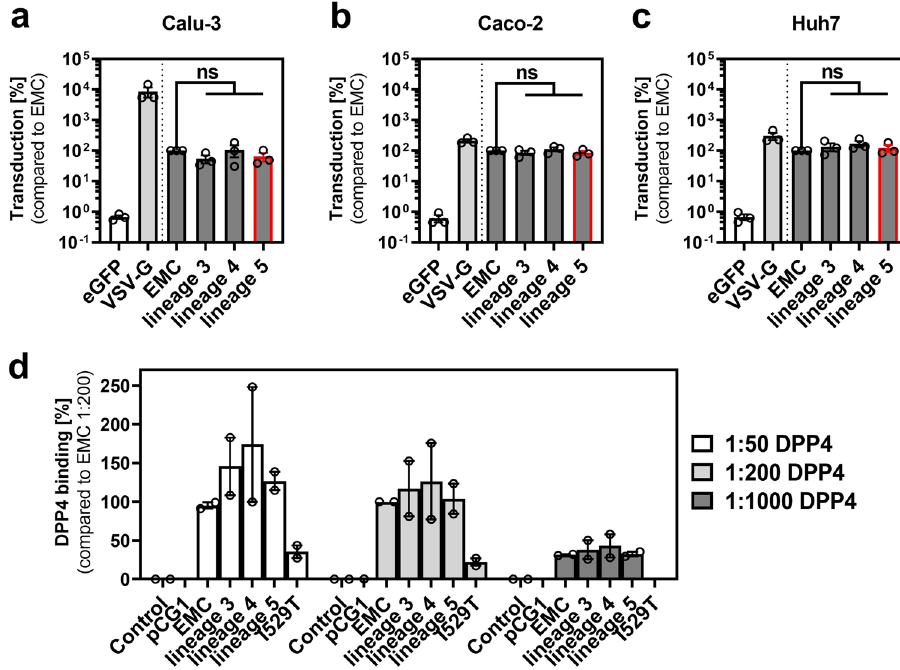
MERS-CoV spike proteins of the EMC isolate, lineage 3, lineage 4, and lineage 5, VSV-G (positive control), or eGFP (negative control) were inoculated onto TMPRSS2-expressing Calu-3, Caco-2, and TMRPSS2 negative Huh7 cells. Transduction ef fi ciency was quanti fi ed at 18 h post transduction by